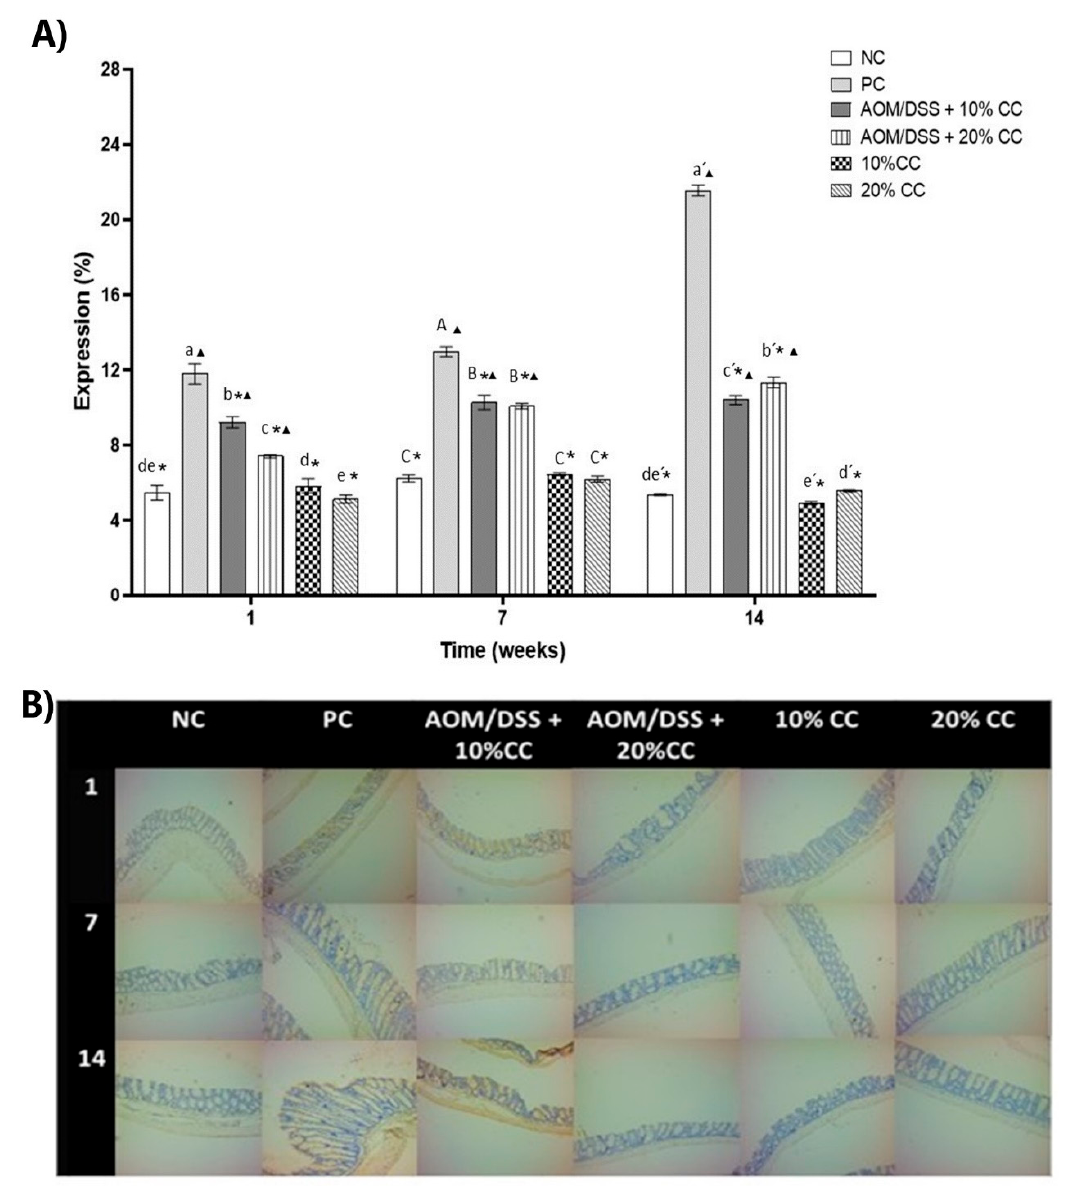
Figure 5. ( A ) Percentage of 4-hydroxy-2-nonenal (4-HNE) expression in the middle portion of the colon of BALB/c mice administered with AOM/DSS in three periods. ( B ) Representative images of the histology of the colonic mucosa by immunohistochemistry in the middle portion on Weeks 1, 7, and 14. Magnification 10x. Lowercase letters correspond to Week 1, uppercase letters correspond to Week 7, and raw letters correspond to Week 14. * means significant difference from the PC in the same evaluation week and ▲ significant difference with respect to the NC in the same evaluation week. One-factor ANOVA ( p < 0.05), Dunnett’s test. Different letters indicate significant difference ( p < 0.05) in the same evaluation week by Tukey’s test. Values are presented as the means ± S.D. from three experimental replicas.